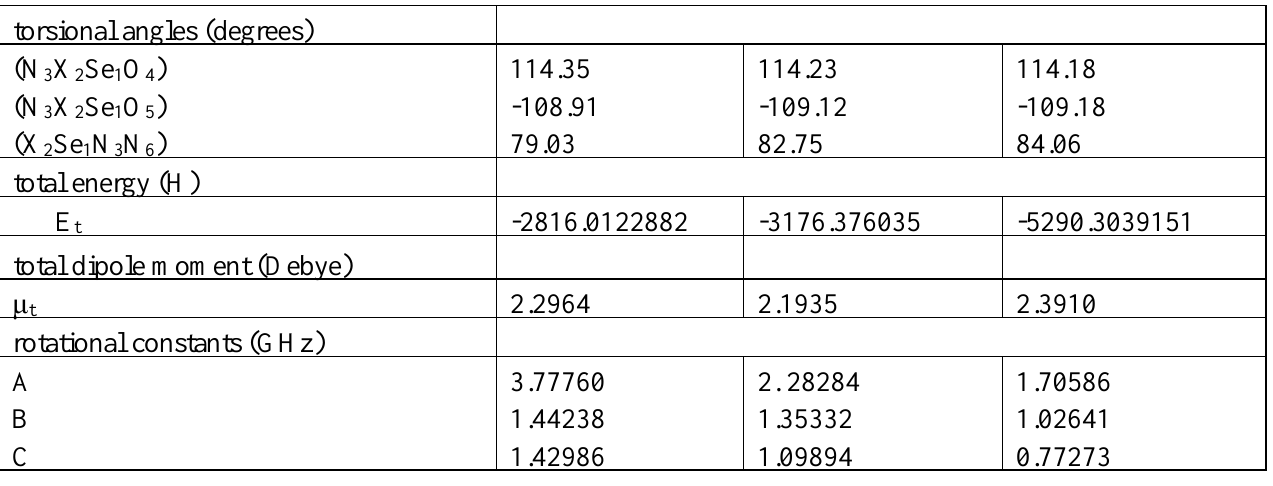
Table 2 : Calculated potential constants in kcal/mol (see equation in the text) for the torsional potentials in the three haloselenonyl azides (X = F, Cl and Br) together with the root mean square deviations, rms in kcal/mol, for the fits, as well as E Hartree to which the relative energies refer (all on DFT/B3LYP